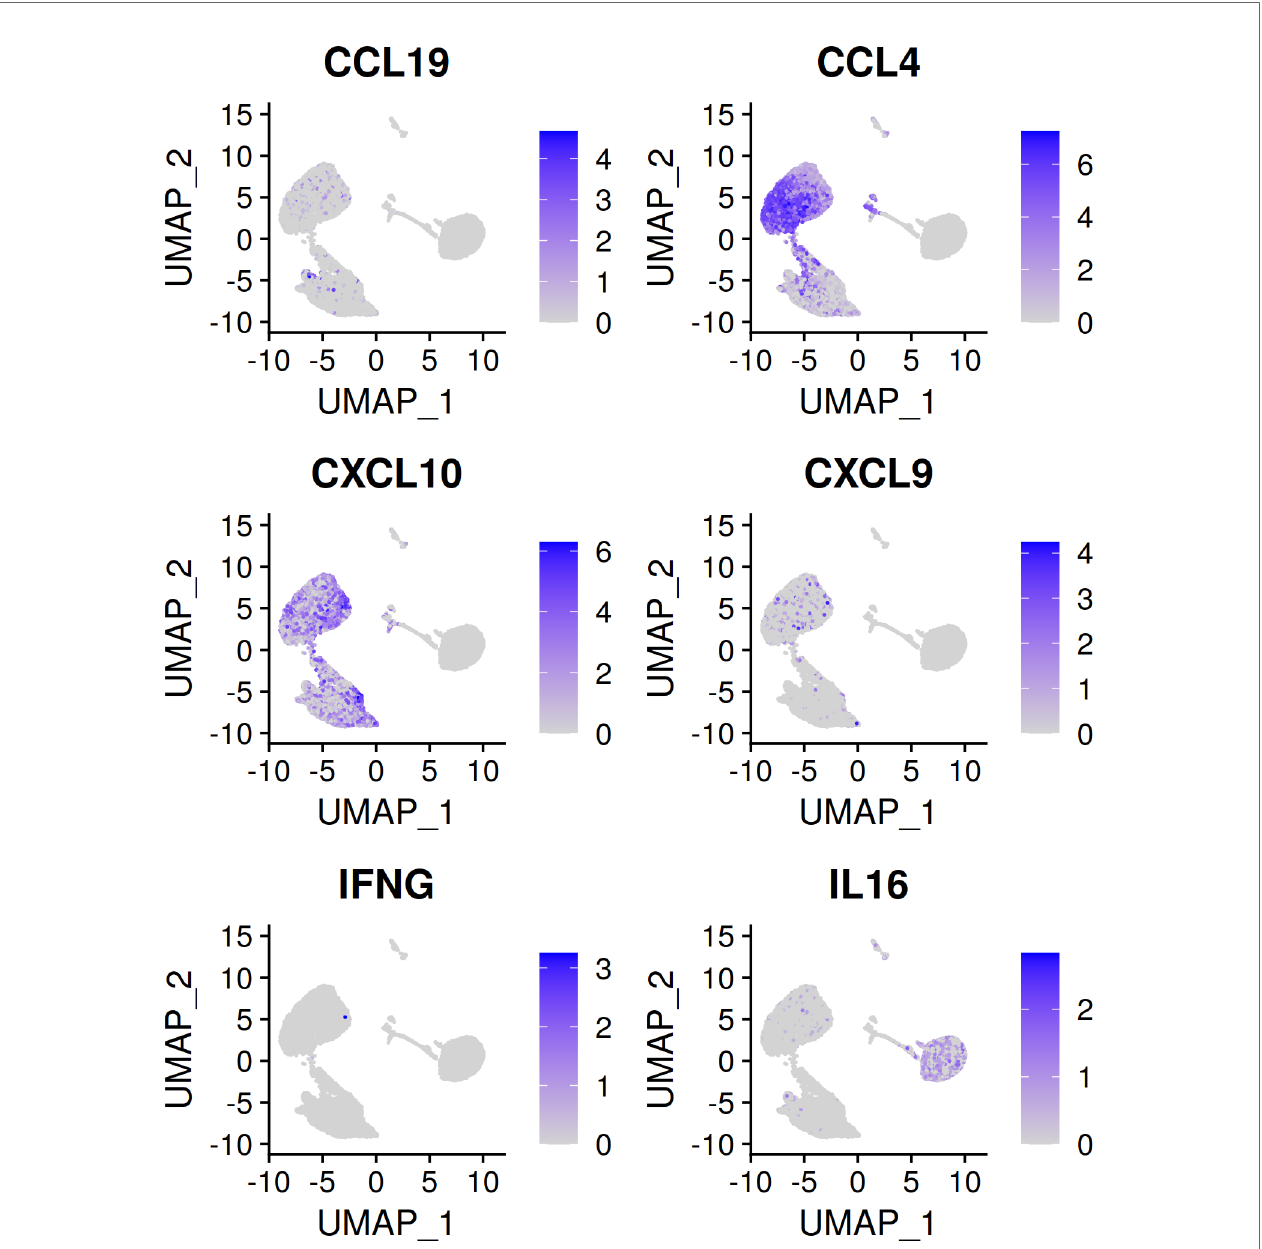
FIGURE 7 | Cytokines/chemokines identi fi ed by LC-MS/MS and corresponding transcript presence in the scRNA-seq dataset. CXCL10 is a known pDC chemokine and is upregulated in pDCs upon fl u virus treatment. CCL4 can be attributed to pDCs on the basis of upregulation with fl u virus seen here. IFNG is not known to be a pDC cytokine, the absence of IFNG in the scRNA-seq dataset con fi rms the non-pDC origin of this cytokine in the secretome experiment. IL-16 is identi fi ed in the secretome data as enriched in the unstimulated condition. This fi nding is supported by the observation that ex vivo pDCs express IL16, whereas fl u virus treated pDCs do